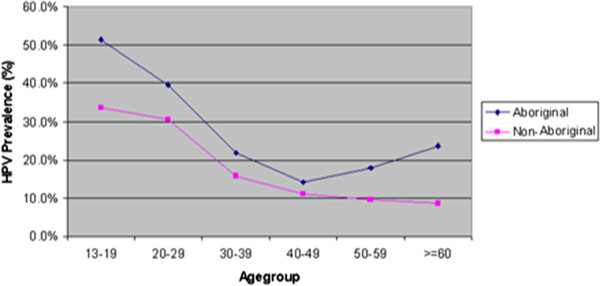
HPV prevelance by agegroup among Aboriginal and Non-Aboriginal women in NWT, Nunavut Labrador and Yukon, Canada.